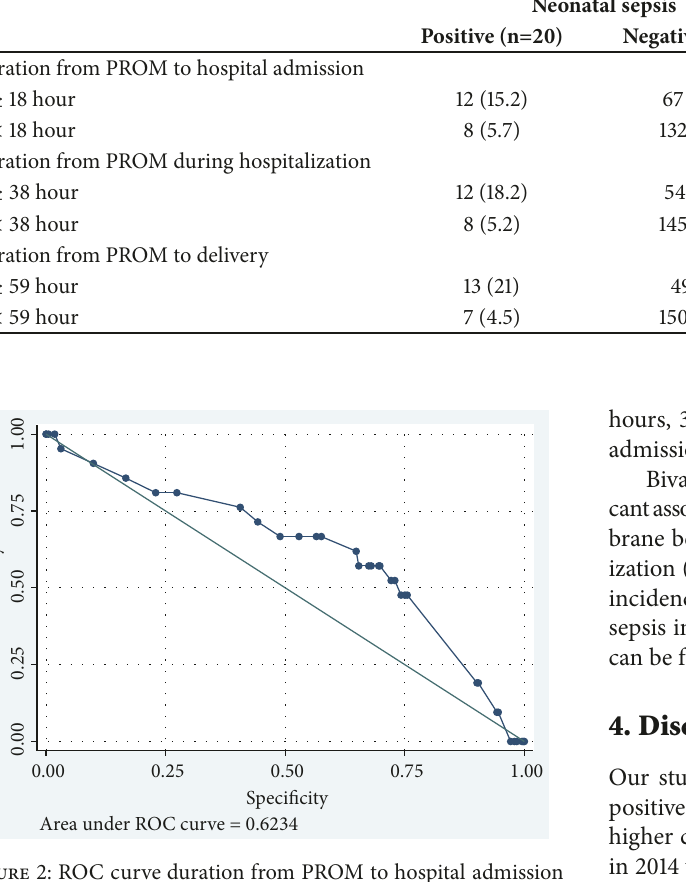
Table 5: Bivariate analysis of duration of premature rupture of membrane with neonatal sepsis in preterm PROM < 37 weeks in RSCM, 2016. Neonatal sepsis